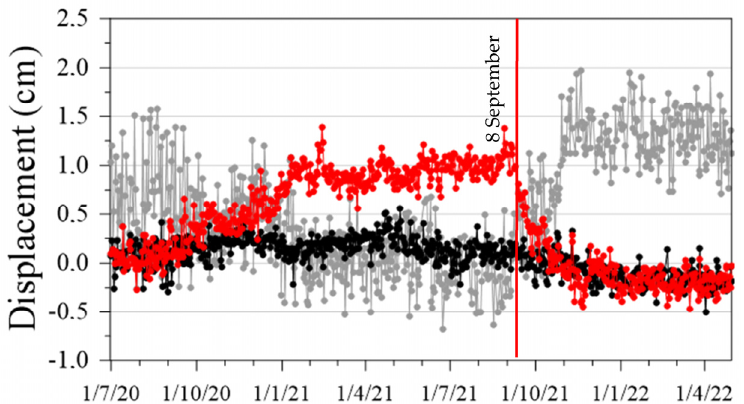
Figure 18. N-S (red circles), E-W (black circles), and vertical components (grey circles) of the IVLT Figure 18. N ‐ S (red circles), E ‐ W (black circles), and vertical components (grey circles) of the IVLT (Lentia) GNSS station located southwest of the La Fossa crater (Lentia) GNSS station located southwest of the La Fossa crater area.